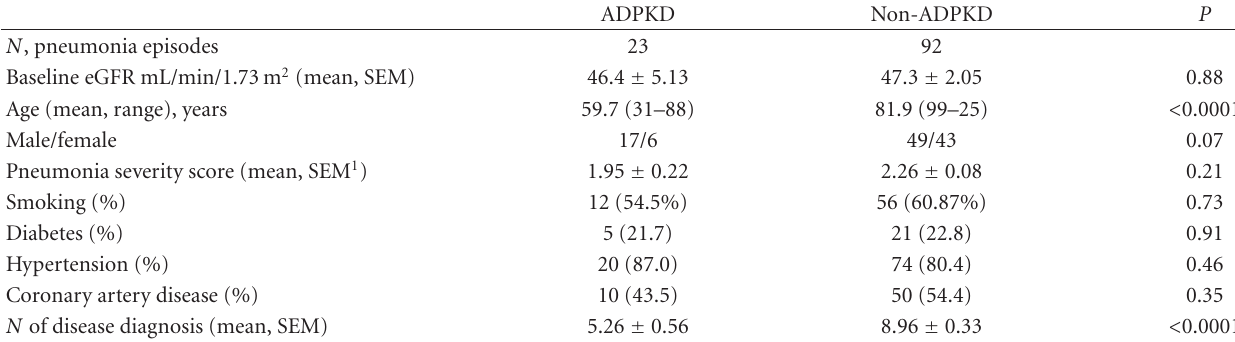
Table 1: Baseline characteristics of patients with and without ADPKD.